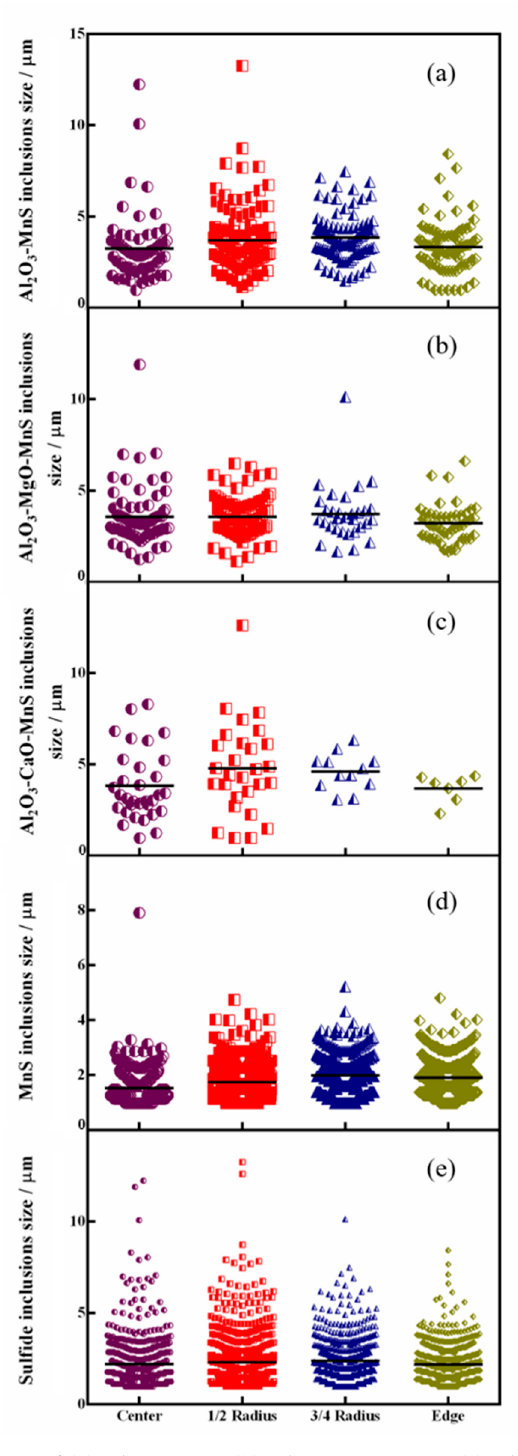
Figure 6. Size distribution of ( a ) Al 2 O 3 -MnS, ( b ) Al 2 O 3 -MgO-MnS, ( c ) Al 2 O 3 -CaO-MnS, ( d ) MnS, and ( e ) all sulfide inclusions at different locations.